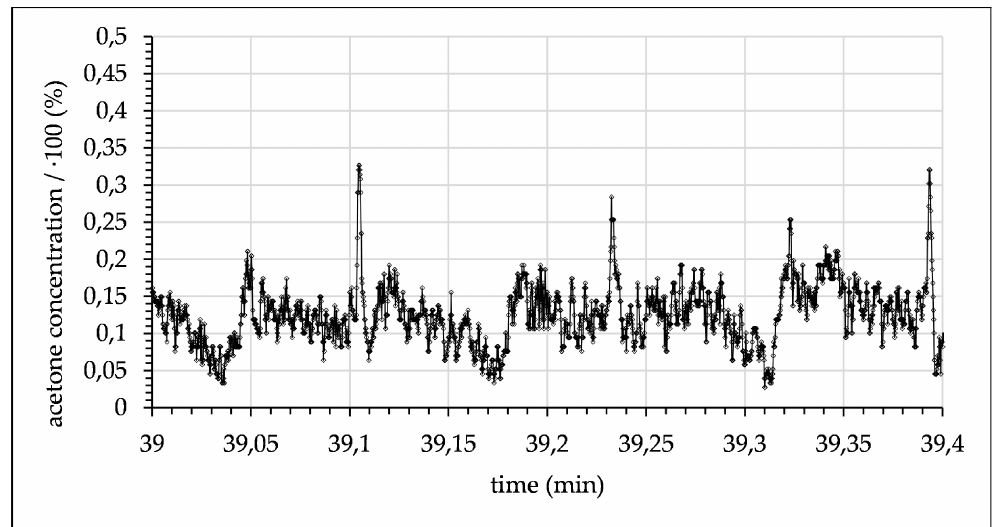
Figure 12. Measured acetone concentration in toluene droplets alternating with water phase (0.014 mL/min with a 10.71 s time delay after contact of toluene and water).